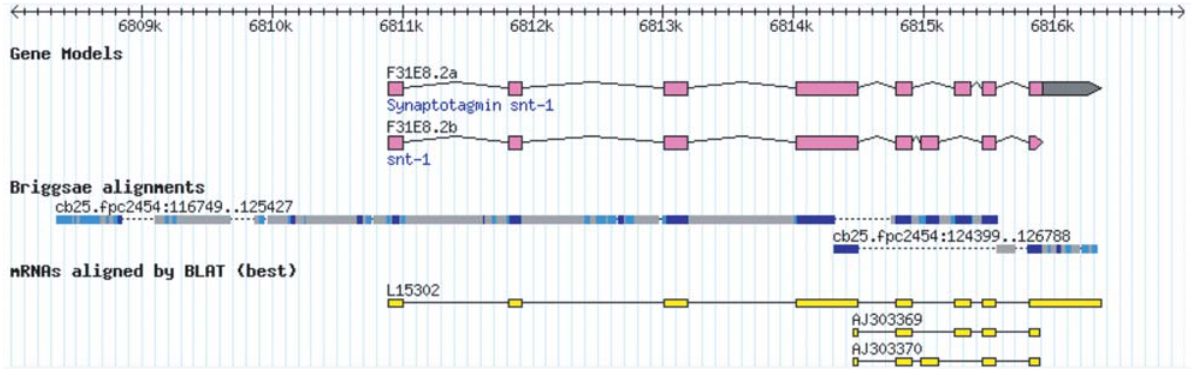
Figure 4. A WABA Alignment over a Known C. elegans Gene (snt-1) WABA coding segments are shown as dark blue, strong alignments as medium blue, and weak alignments as grey. Regions that do not align are shown as dotted lines. The alignments of three sequenced C. elegans mRNA sequences are also shown for